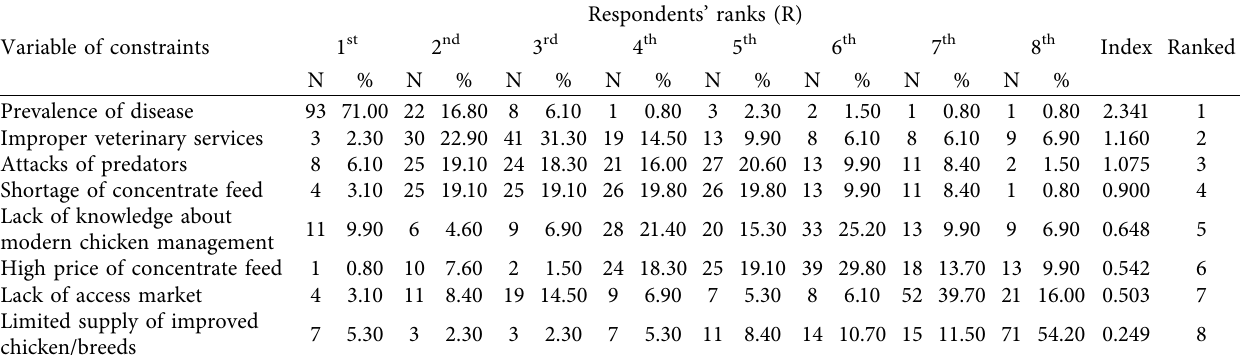
Table 4: Ranking of constraints of improved chicken production in the study area.